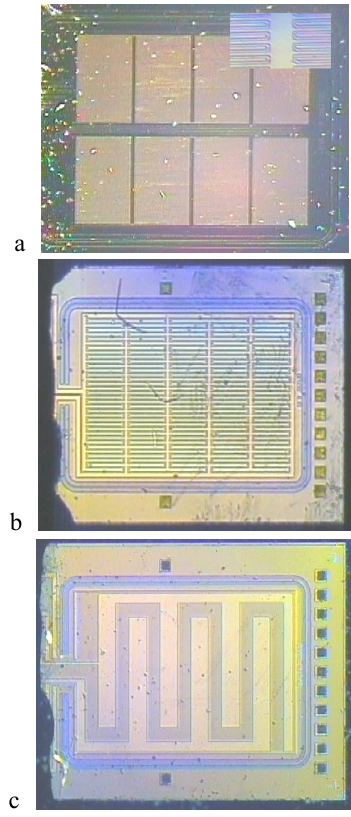
Fig.8: Interdigitated electrodes with different structural dimension a) 3 µm (enlarged vie in insert image), b) 20 µm and c) 150 µm, developed by CiS Forschungsinstitut für Mikroelektronik